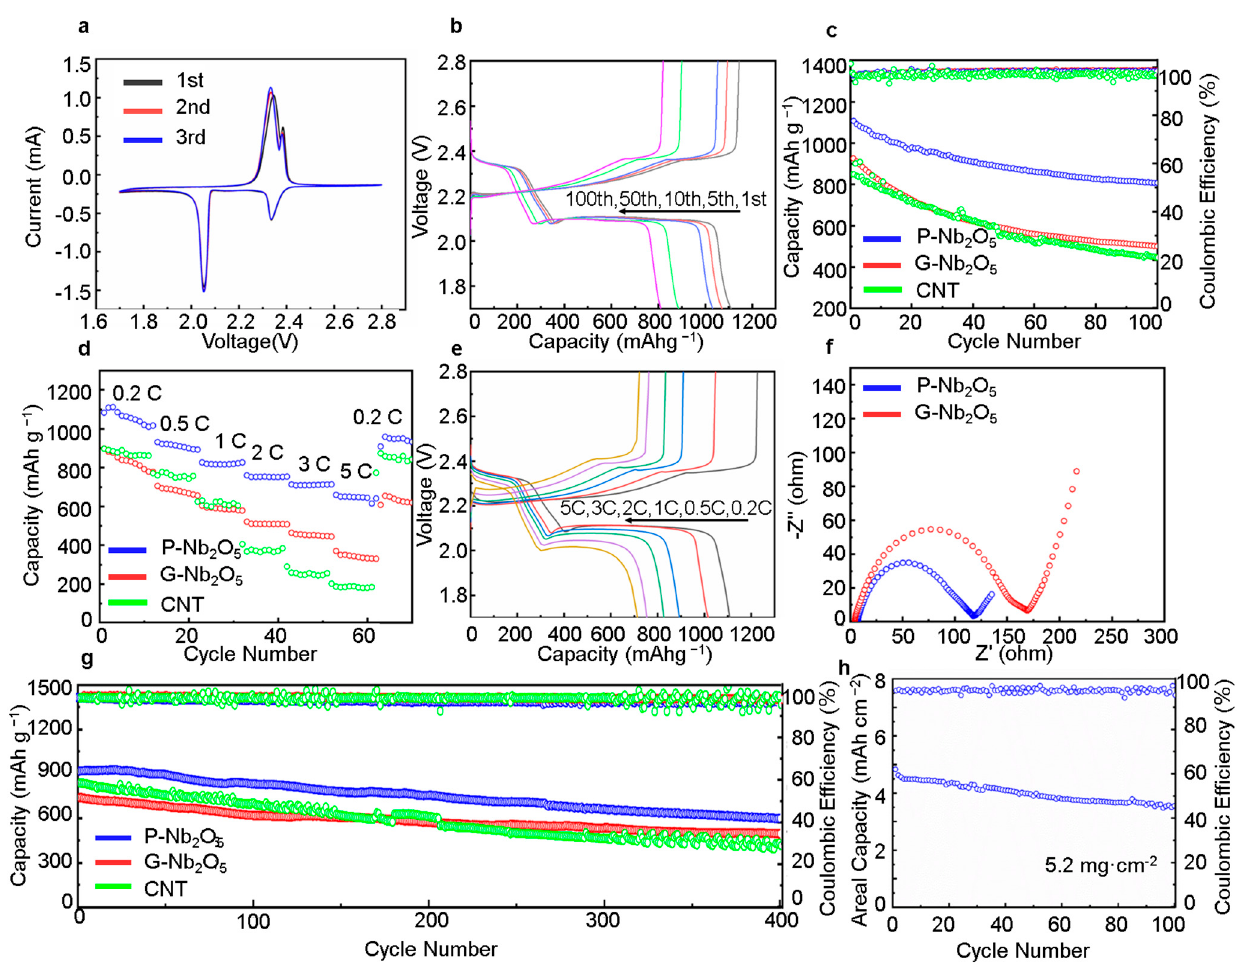
Figure 5. ( a ) CV curves of the batteries with the P-Nb 2 O 5 cathodes. ( b ) Discharge/charge curves at 0.2 C. ( c ) Cycling performances of the P-Nb 2 O 5 , G-Nb 2 O 5 , and CNT electrodes at 0.2 C for 100 cycles. ( d ) Cycling performances of the P-Nb 2 O 5 , G-Nb 2 O 5 , and CNT electrodes at different current rates (between 0.2 and 0.5). ( e ) Charge/discharge performances at different current rates (between 0.2 and 0.5). ( f ) EIS spectra of the batteries with the P-Nb 2 O 5 and G-Nb 2 O 5 electrodes. ( g ) Long-time cycling diagram for the P-Nb 2 O 5 , G-Nb 2 O 5 , and CNT cathodes at 1 C. ( h ) High load cycle performance graph for the P-Nb 2 O 5 .